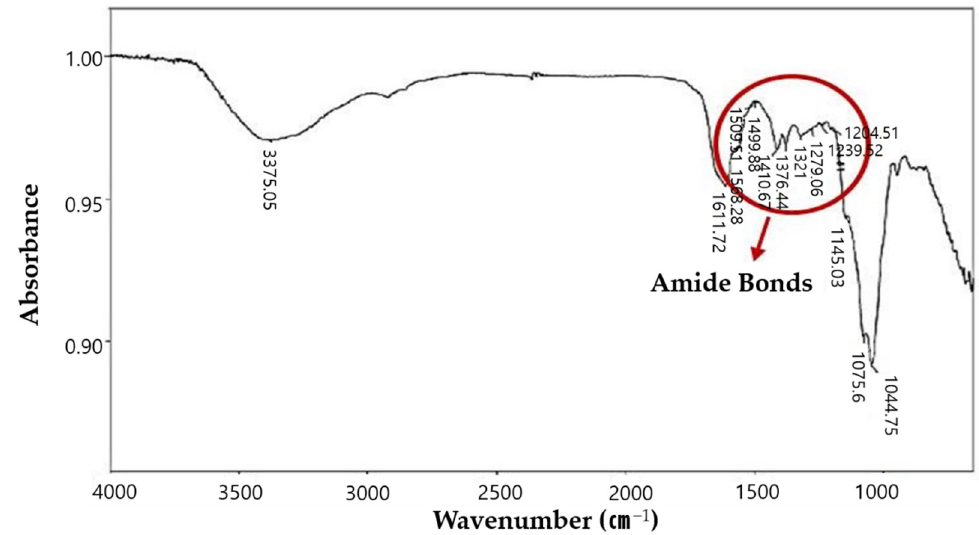
Figure 5. Fourier transform infrared spectroscopy. Spectrum of HA-collagen hydrogel. Infrared spectrometry showed the presence of amide bonds which are the reaction outcome of adipic dihydrazide (ADH) and oxidized HA. HA, hyaluronic acid.